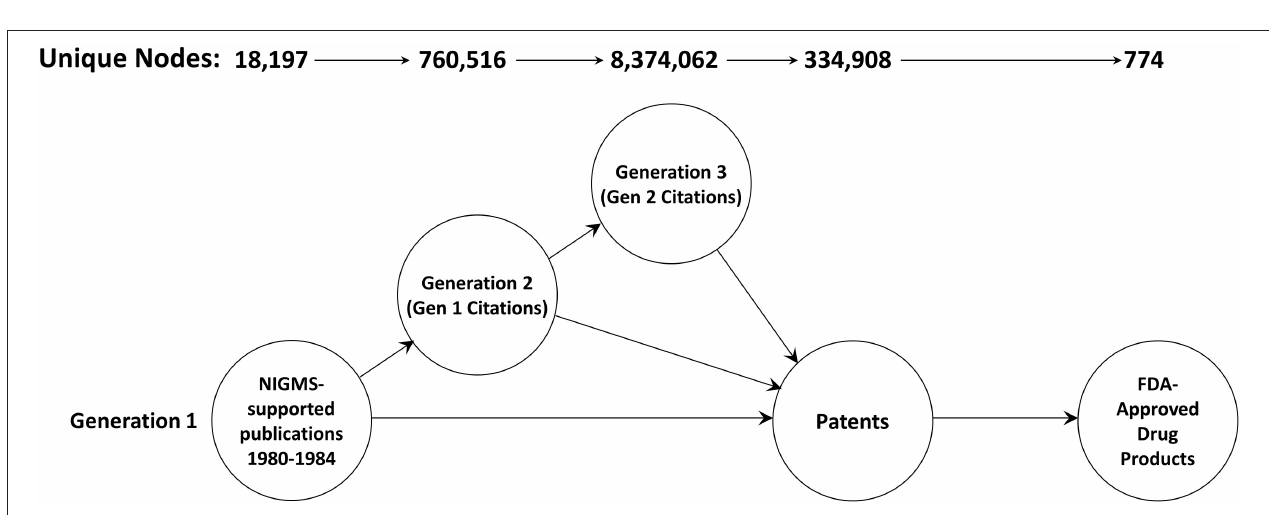
FIGURE 2 | The three-generation publication network. This is a forward trace of 18,197 publications in 1980–1984 citing support from NIGMS.